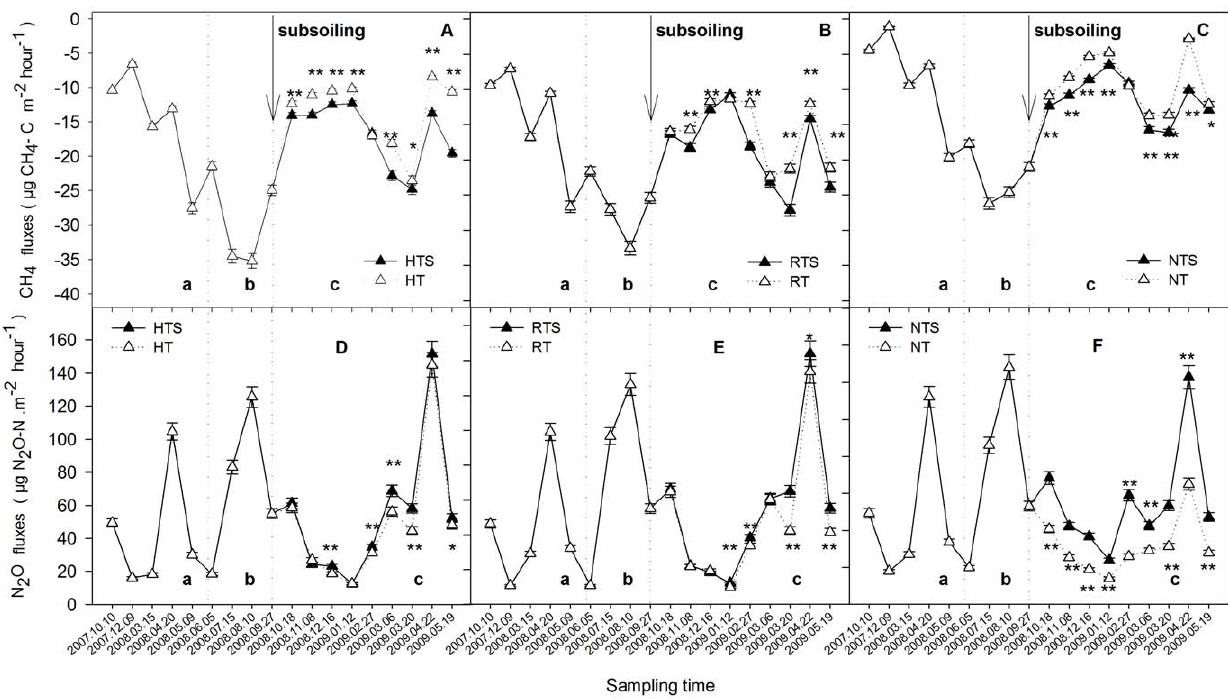
Figure 2. A to C CH 4 flux variations of H, R, and N after subsoiling in different periods; D to F N 2 O flux variations of H, R, and N after subsoiling in different periods. a in Fig. 2 is the wheat growth stage of 2007 to 2008; b is the maize growth stage of 2008 to 2009; c is the wheat growth stage of 2008 to 2009. Arrows indicate time of subsoiling. Dotted lines distinguish the growth period of wheat and maize. * indicates P , 0.05 and **indicates P , 0.01 between subsoiling and the control. doi:10.1371/journal.pone.0051206.g002 surface temperature and the soil temperature at a depth of 5 cm were determined after collecting samples. Table 1. GWP and total changes in CH 4 and N 2 O after The samples were measured using a Shimadzu GC-2010 gas subsoiling (2008.10 , chromatograph. CH 4 was measured using a flame ionization detector with a stainless steel chromatography column packed with a 5A molecular sieve (2 m long); the carrier gas was N 2 . The temperatures of the column, injector and detector were 80 u C, 100 u C and 200 u C, respectively. The total flow of the carrier gas was 30 ml min 2 1 , the H 2 flow was 40 ml min 2 1 , and the airflow was 400 ml min 2 1 . N 2 O was measured using an electron capture detector with a Porapak-Q chromatography column (4 m long); the carrier gas was also N 2 . The temperatures of the column, injector and detector were 45 u C, 100 u C and 300 u C, respectively. The total flow of the carrier gas was 40 ml min 2 1 , and the tail- blowing flow was 40 ml min 2 1 . The gas fluctuations were calculated by the gas concentration change in time per unit area.